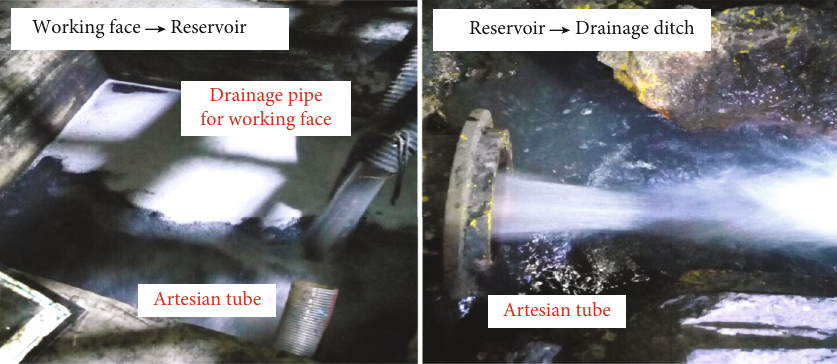
Figure 6: Underground gushing and drainage situation.